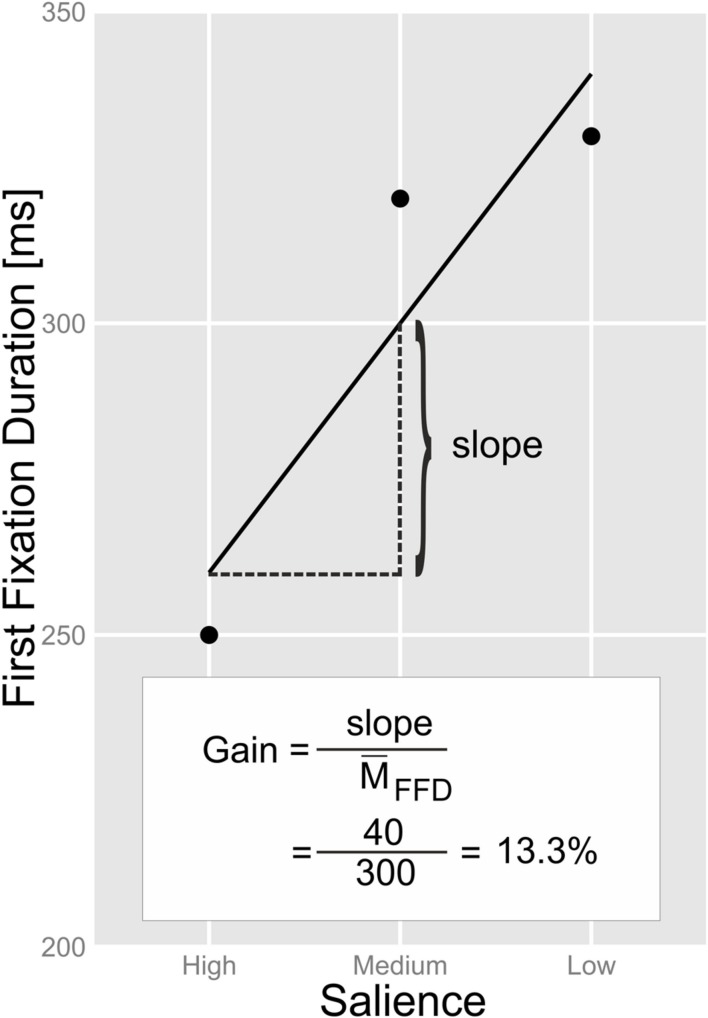
Exemplary illustration of our procedure of estimating the “gain” that parafoveal preprocessing provides for the subsequent foveal processing of the target words. The proportion [p] of gain was multiplied by 100 in order to achieve a gain estimate in the unit of percentage.